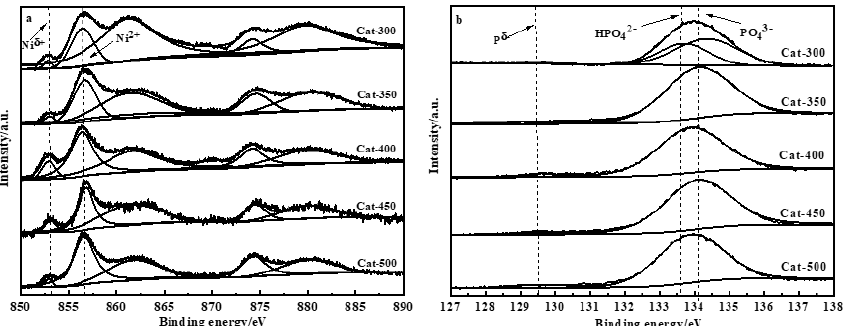
Figure 3. XPS patterns in the Ni 2p and P 2p regions of different Ni 2 P/Al 2 O 3 catalysts ( a ) Ni 2p ( b ) P 2p. ( b ) P